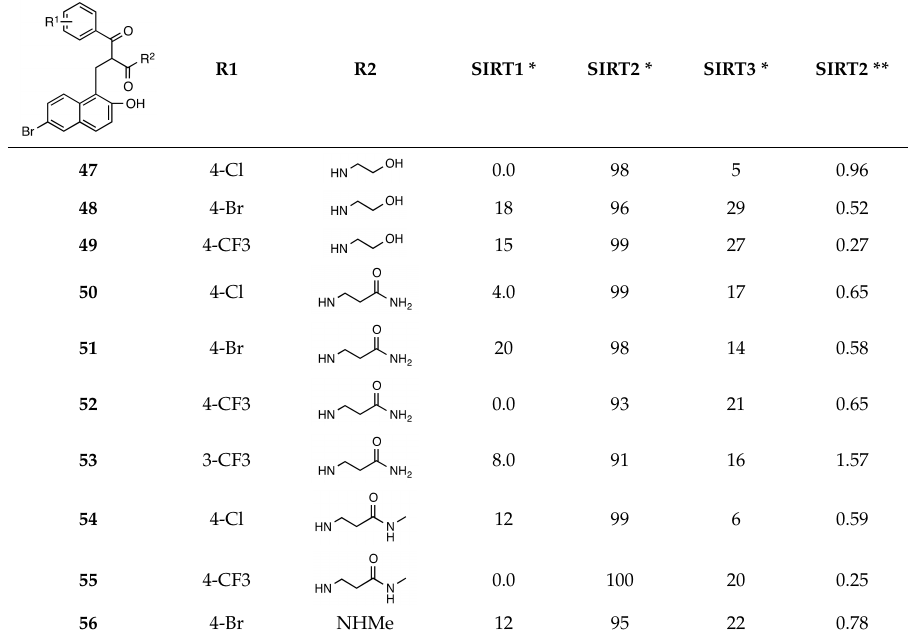
Table 4. Optimization of the SIRT2 inhibitors (R 1 and R 2 ).